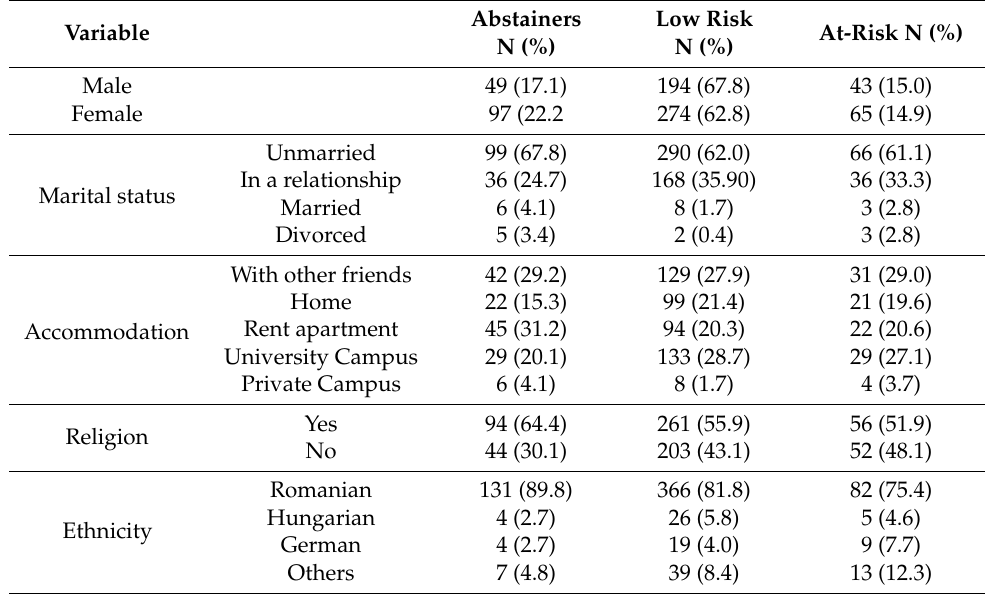
Table 1. Participant’s sociodemographic and family characteristics.